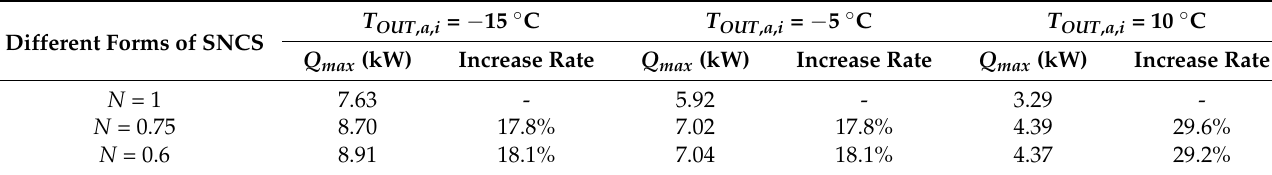
Table 5. Heat transfer rate under different forms.